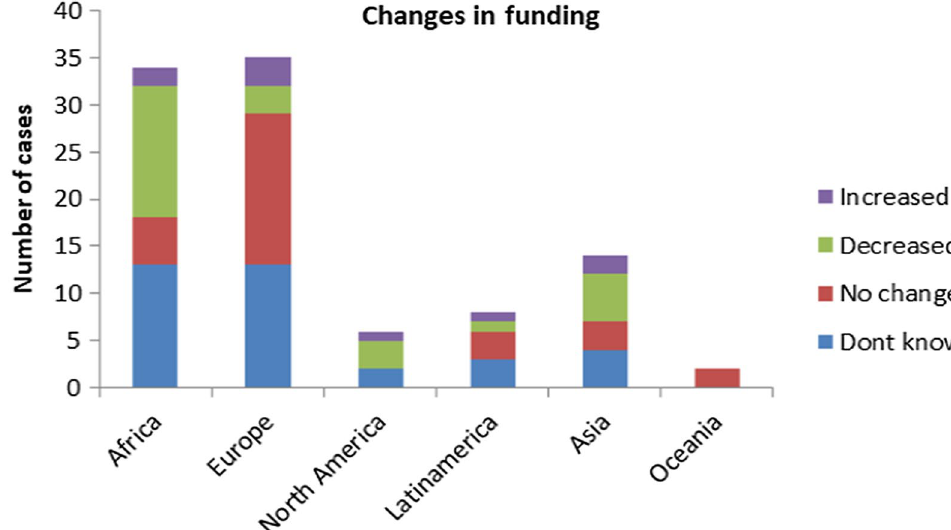
Fig. 4 Changes in funding across geographical